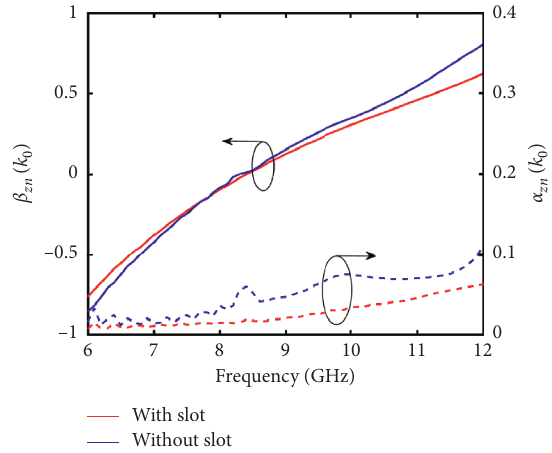
Figure 14: The comparison of propagation constant of proposed antenna with and without